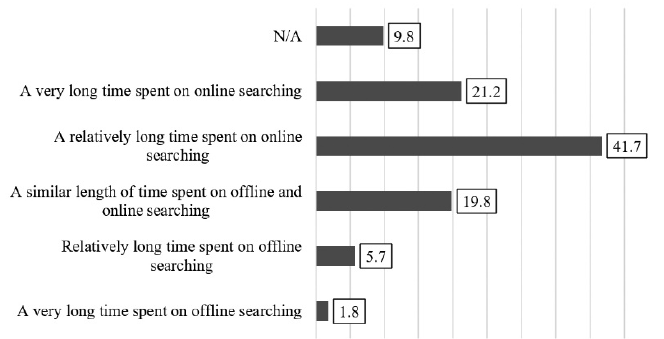
Figure 3. Perception of time spent searching for information related to healthy nutrition on online and offline platforms, % ( n = 612).